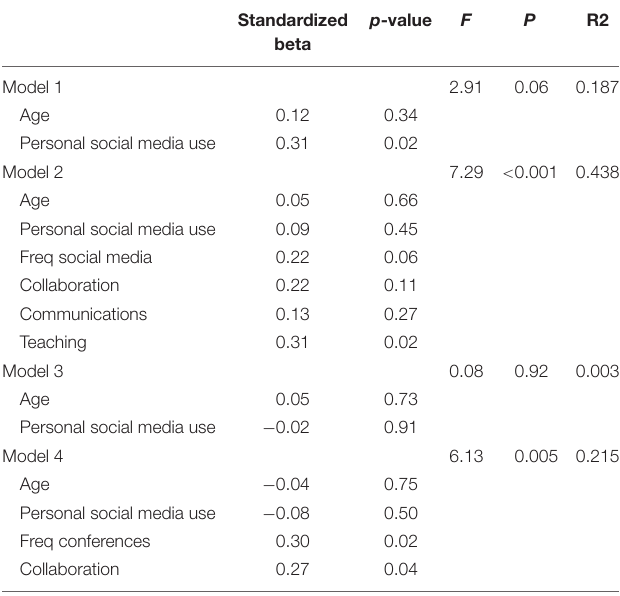
TABLE 5 | Results of linear regression analyses for social media (models 1 and 2) and conferences (Models 3 and